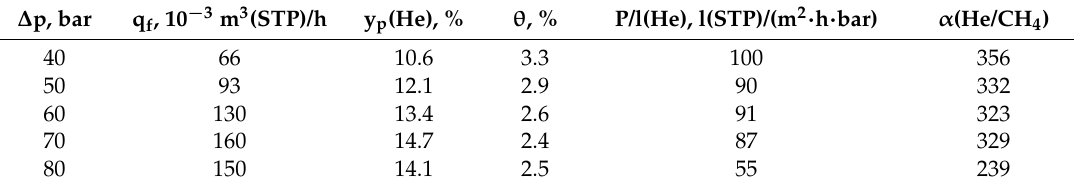
Table 3. The influence of transmembrane pressure on feed flow rate (q f ), helium concentration in permeate (y p ), stage cut ( θ ), and separation